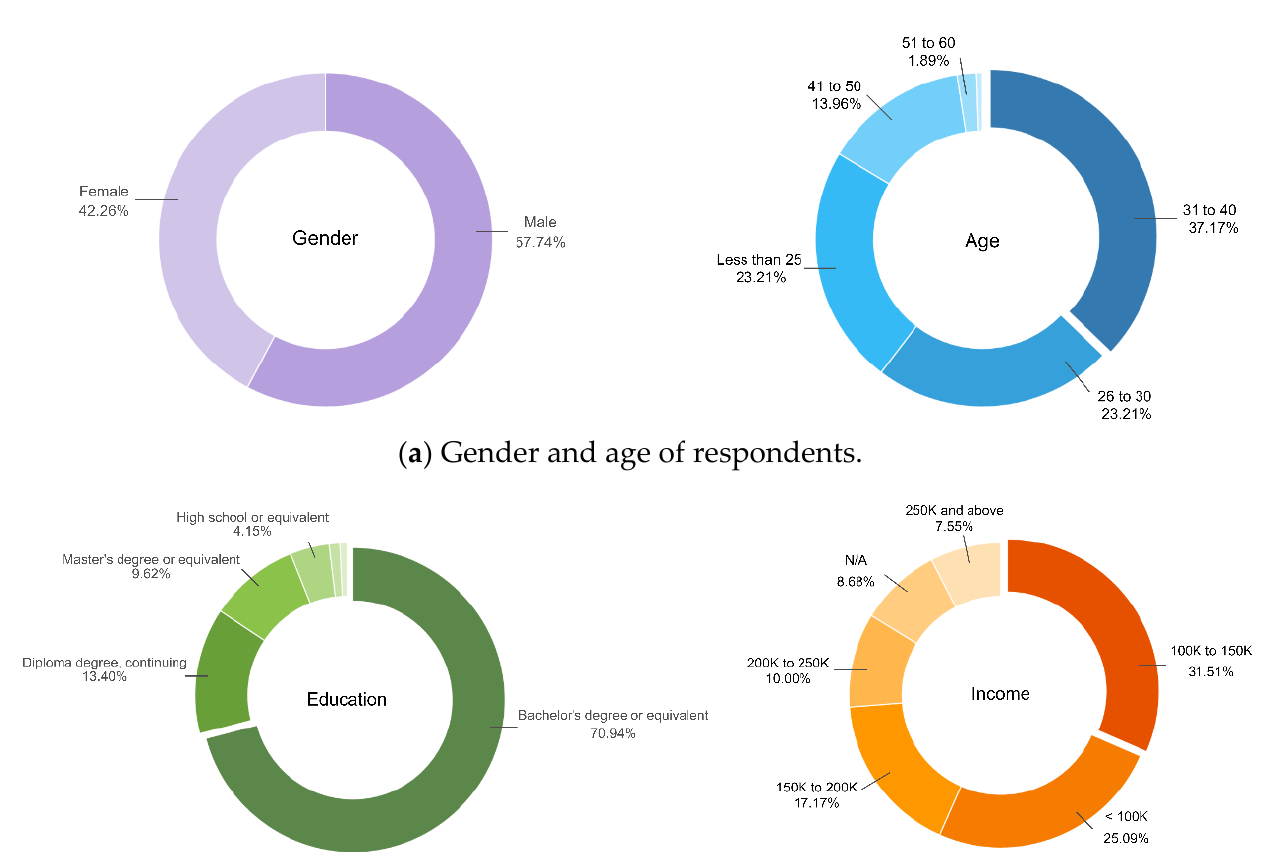
Figure 3. The respondent profiles.